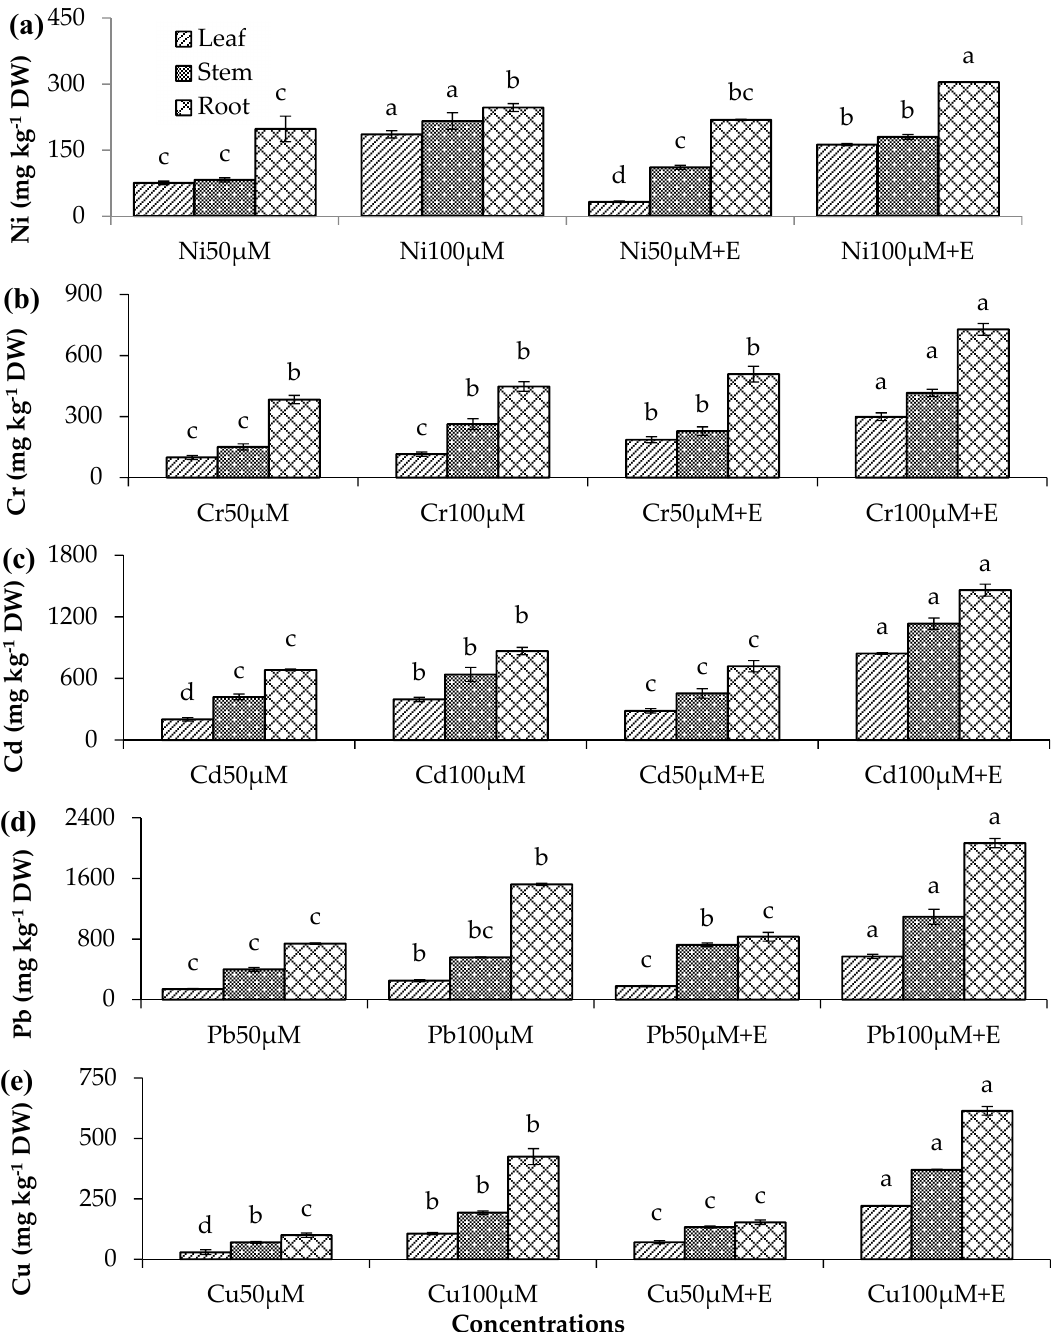
Figure 2. Metal accumulation in the leaves, stems, and roots of Celosia argentea , Ni ( a ), Cr ( b ), Cd ( c ), Pb ( d ) and Cu ( e ). Exposure at 50 µM and 100 µM MCs without and with 2.5 mM EDTA (E). According to the Duncan test, different letters above the bars denote significant difference at significance level p < 0.05, with “a” being significantly highest uptake followed by the other letters for respective plant compartment. Each bar is a mean of three replicates ± SE. For Pb, accumulation was maximum at the highest dose of Pb with EDTA. At lower concentrations, there was no significant difference in the accumulation of Pb in leaves and roots. However, at a higher metal dose, accumulation improved in all three plant parts with EDTA. In all three parts, maximum accumulation was found at 100 µM Pb + EDTA